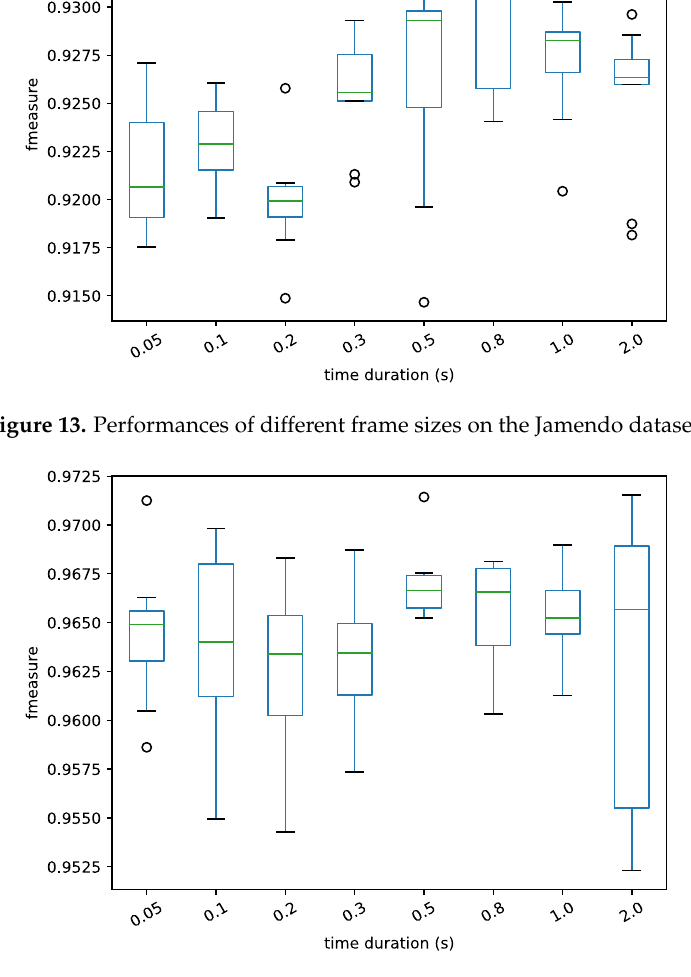
Figure 14. Performances of different frame sizes on the RWC